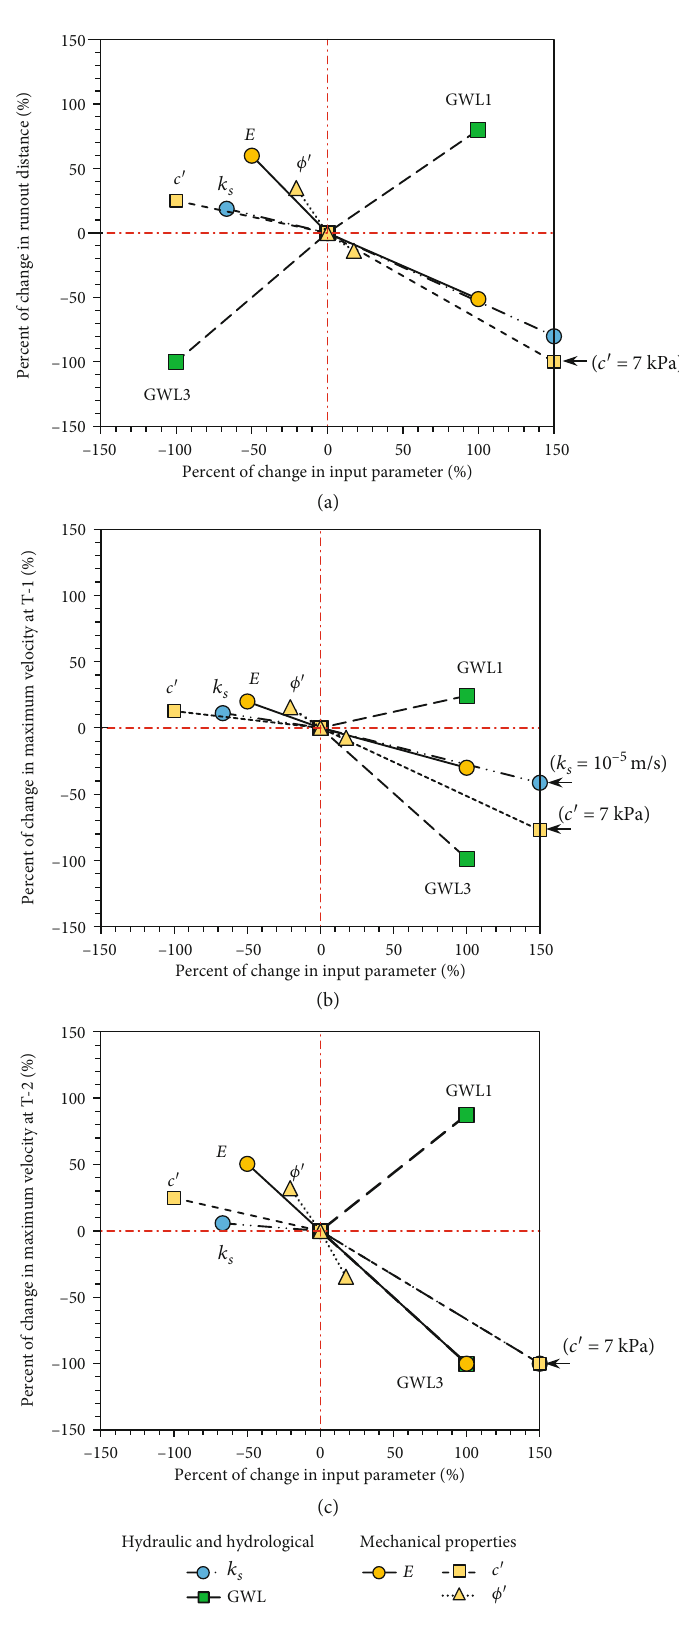
Figure 15: Results of sensitivity assessment in: (a) runout distance, (b) velocity of T-1, and (c) velocity of